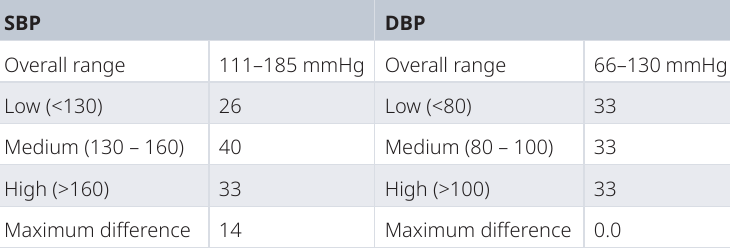
Table 4. Observations (n) in each SBP and DBP recruitment